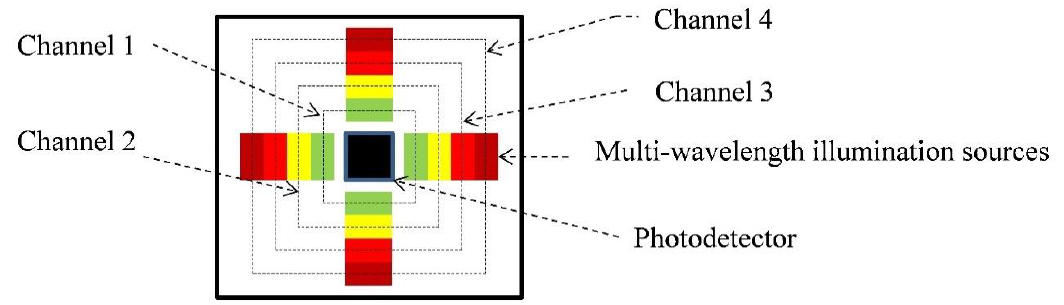
Figure 1. Multi-wavelength opto-electronic patch sensor (mOEPS). Each channel has four LEDs: Channel 1, green LEDs; Channel 2, orange LED; Channel 3 red LEDs; and Channel 4, IR LEDs.